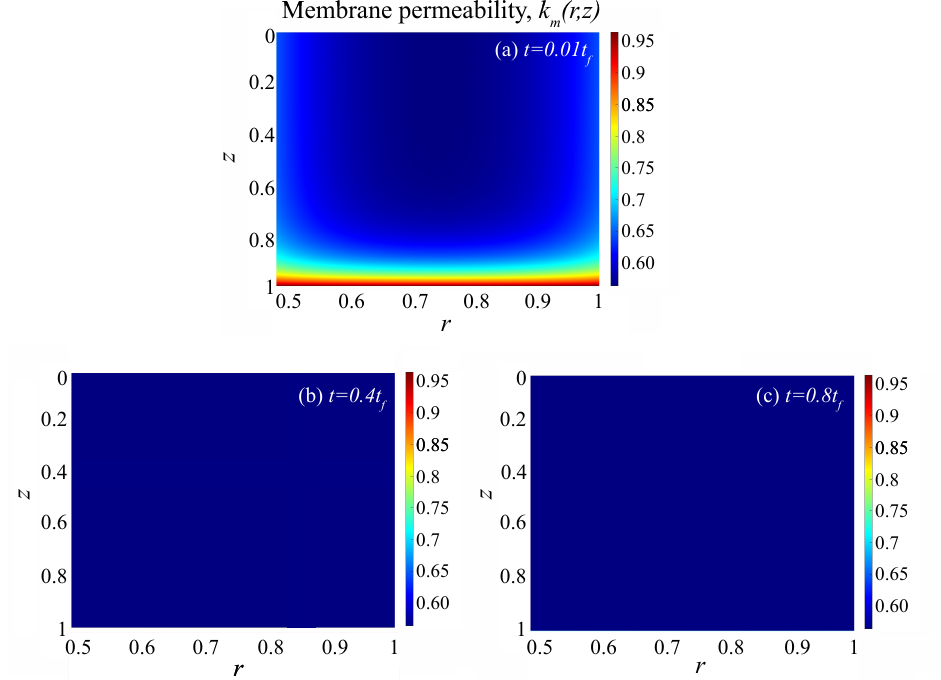
Figure 5. Contour plot showing membrane permeability k m ( r , z ) at times ( a ) t = 0.01 t f , ( b ) t = 0.4 t f , and ( c ) t = 0.8 t f . Parameter values are φ = 0.5, l = 0.5, Γ = 10, N = 1, β = 0.02, ρ b = 2, b = 0.5, and (cid:101) ∗ =